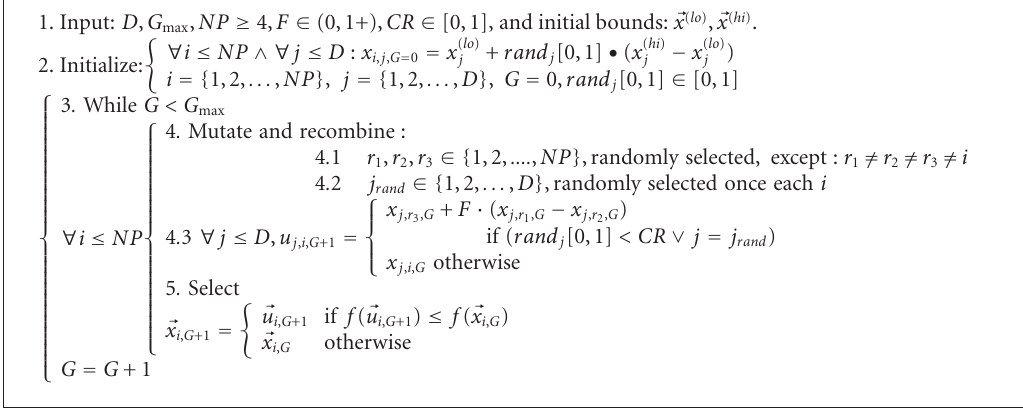
Pseudocode 2: Pseudocode of DE.